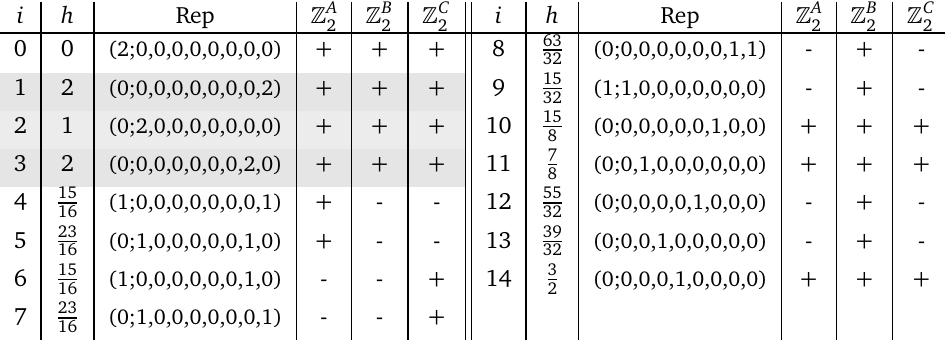
, (cid:90) B , (cid:90) C , 2 2 2 × (cid:90) 2 2